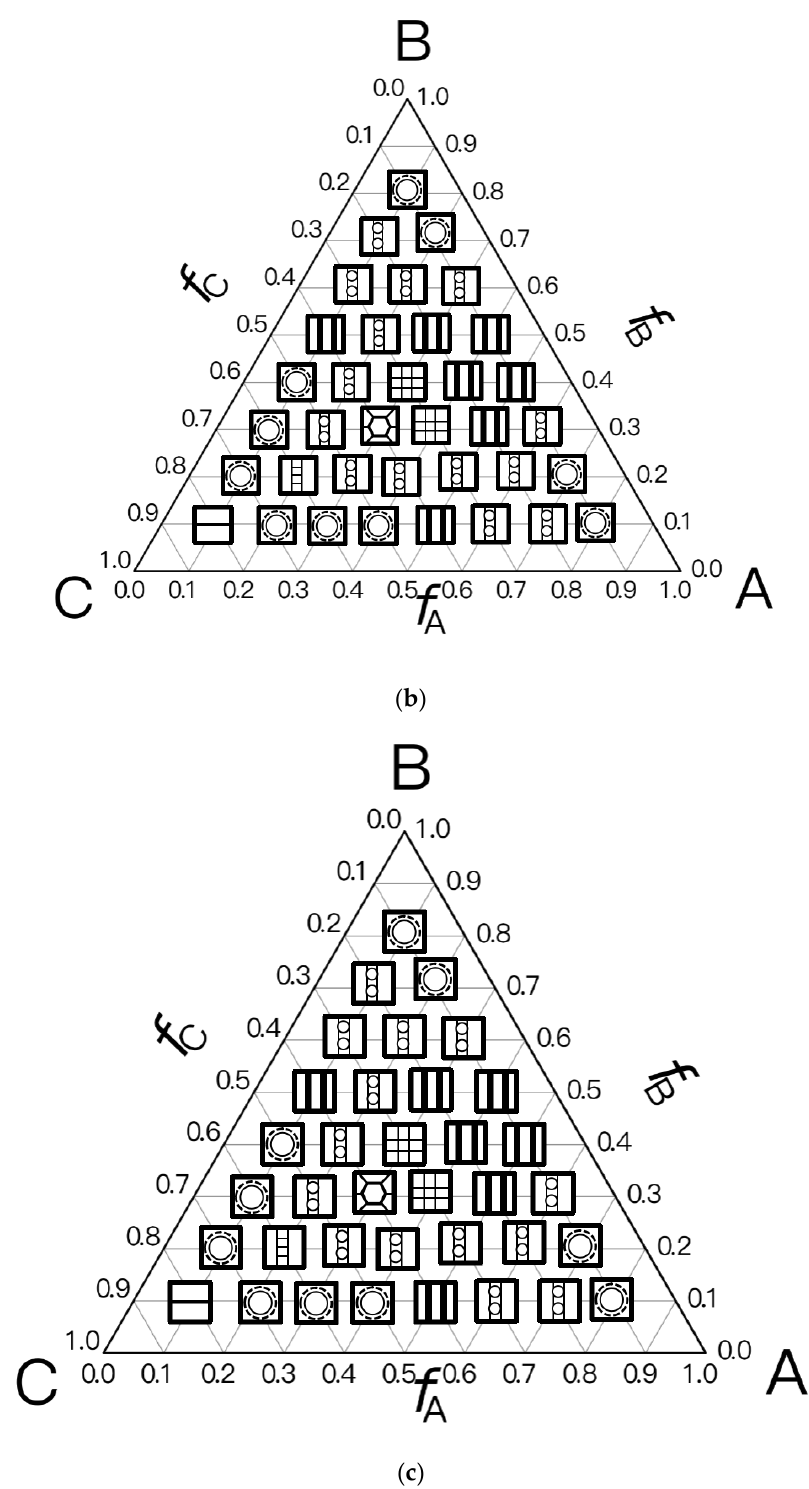
Figure 3. The triangle phase diagrams for the Janus double-brush copolymer (AC 2 B) n containing n star subunits in its sequence at χ AB N = χ BC N = χ AC N = χ N . The χ N / n value is maintained at 35. ( a ) Architectural periodicity n = 2 and segregation strength χ N = 35 × 2 = 70; ( b ) n = 3 and χ N = 35 × 3 = 105; ( c ) n = 10 and χ N = 35 × 10 = 350. In Figure 3b, the phase diagram for the Janus double-brush copolymers (AC 2 B) n with architectural periodicity n = 3 at tripled segregation strengths χ N = 35 × 3 = 105 is